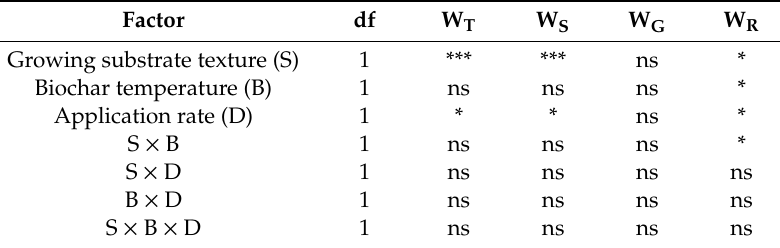
Table 5. Three-way ANOVA results of the e ff ect of growing substrate texture, biochar temperature and application rate on biomass dry weight of sorghum crop in pots experiment. Factor df